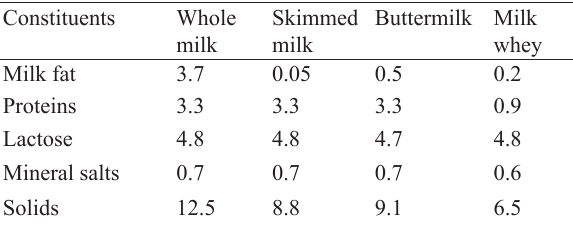
Table 1 Content of the main constituents in dairy raw materials, g/100 g Constituents